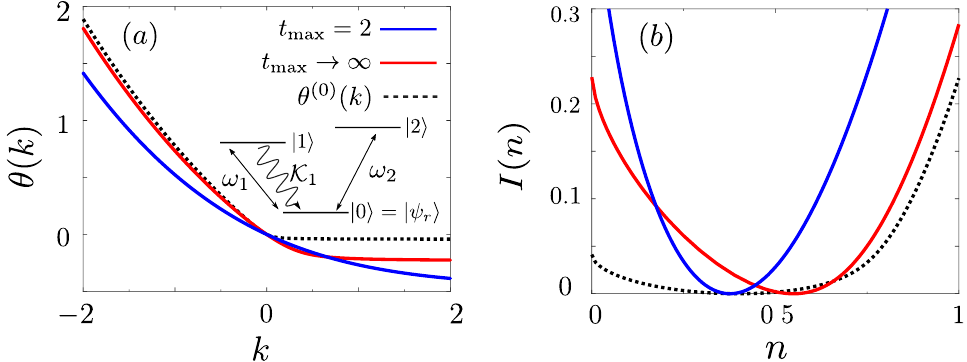
〉 = | 0 〉 . (a) Scaled Figure 5: Three-level system reset to the inactive state | ψ r = 2 (in units of ω − 1 cumulant generating function θ ( k ) as a function of k for t , max 1 → ∞ (red solid line). The SCGF of the reset-free dissipative blue solid line) and t max process θ ( 0 ) ( k ) is shown as a black dashed curve for comparison. The three-level system is also sketched. (b) Rate function I ( n ) as a function of the activity n = N / t for the same values of t as in panel (a). Resetting hinders long inactive periods max and therefore the intermittence of the quantum-jump trajectories. The crossover of θ ( k ) around k = 0 gets therefore smoother and smoother as reset events become more and more frequent (low values of t ). The large deviation function I ( n max